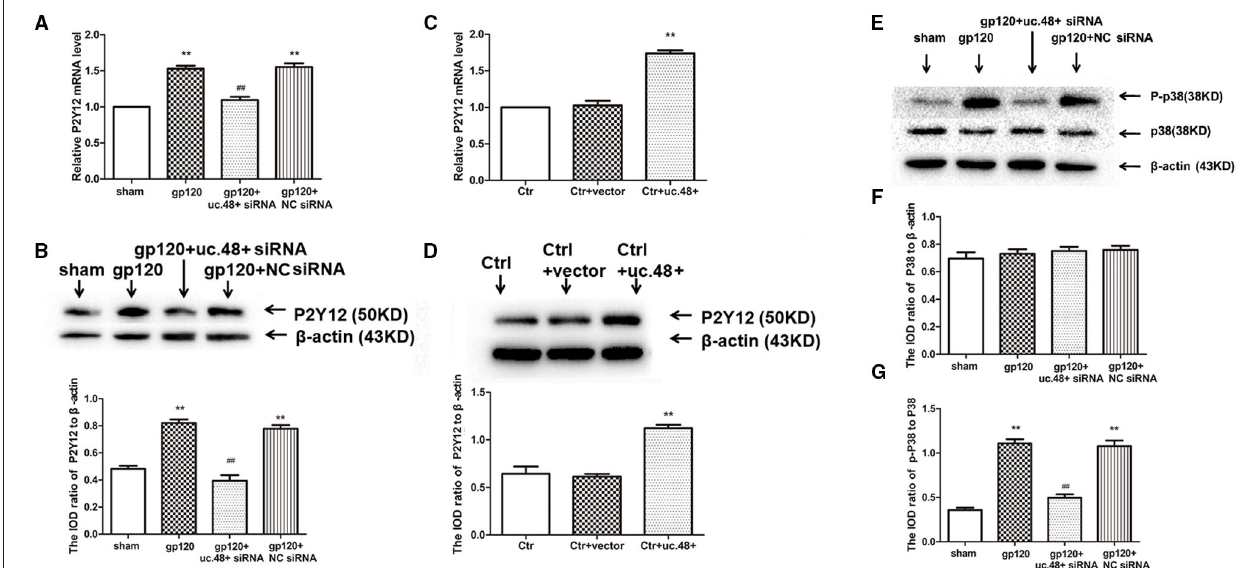
FIGURE 4 | Effects of uc.48 + on P2Y12 receptor expression and activation of P2Y12 downstream P38 MAPK pathway in vivo . Real-time PCR (A) and Western blotting (B) analyses showed siRNA silencing of uc.48 + downregulated P2Y12 receptor expression. n = 10 rats per group. Data are displayed as means ± SEM. ** p < 0.01 vs. sham group, ## p < 0.01 vs. gp120 group. Real-time PCR (C) and Western blotting (D) results showed that overexpression of uc.48 + upregulated P2Y12 receptor levels in control rat DRG. n = 8 rats per group. Data are displayed as means ± SEM. ** p < 0.01 vs. control group. (E–G) Uc.48 + siRNA lowered upregulated p-P38 MAPK levels in gp120 group. n = 10 rats per group. Data are displayed as means ± SEM. ** p < 0.01 vs. sham group, ## p < 0.01 vs. gp120